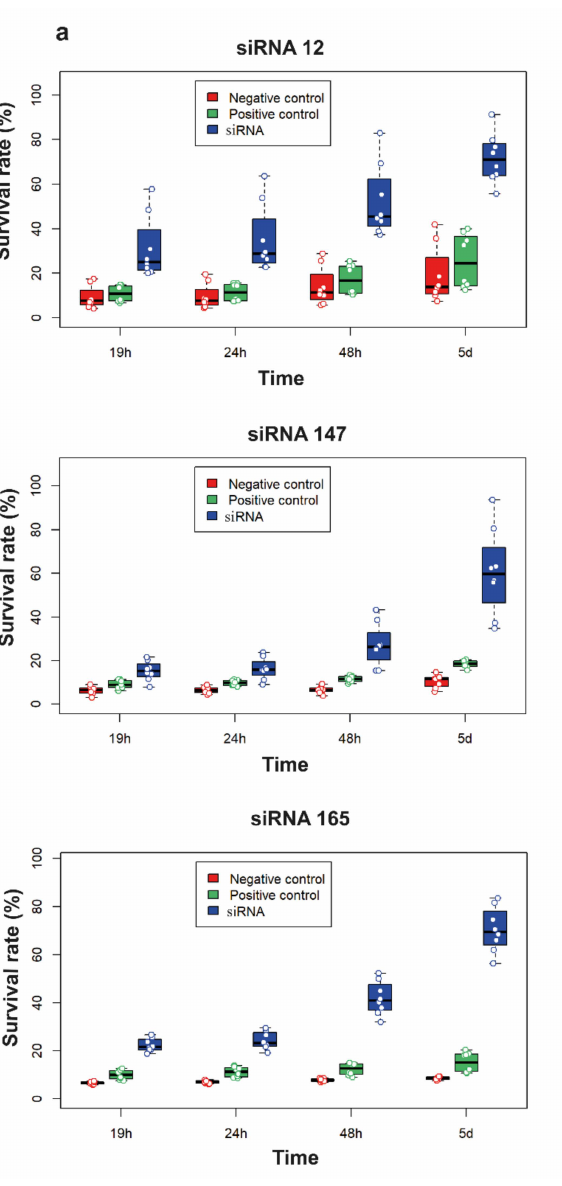
Figure 3. High-throughput validation of the siRNA set conferring oxidative stress resistance to airway epithelial cells. ( a ) Representative spectrophotometric quantification of the mean survival rate of representative test siRNAs (clones 12, 147, and 165; blue), a negative control siRNA (red) and a weak positive control siRNA (clone 171; green) in 6CFSMEo- cells at 19 h, 24 h, 48 h, and 5 days after Alamar Blue reagent addition. n = 8 technical replicates/sample. ( b ) Output of the high-content siRNA screening for oxidative stress resistance in airway epithelial cells. The siRNA sequences examined at 19 h (25 h after oxidative stress induction) could be partitioned into those having large effect size (>0.8), medium effect size (between 0.5 and 0.8), small effect size (between 0.2 and 0.5), very small effect size (between 0.01 and 0.2), and no effect size (<0.01). There were 73 siRNAs with a large effect size, 30 siRNAs with a medium effect size, 39 siRNAs with a small effect size, 29 siRNAs with a very small effect size, and 8 siRNAs with no